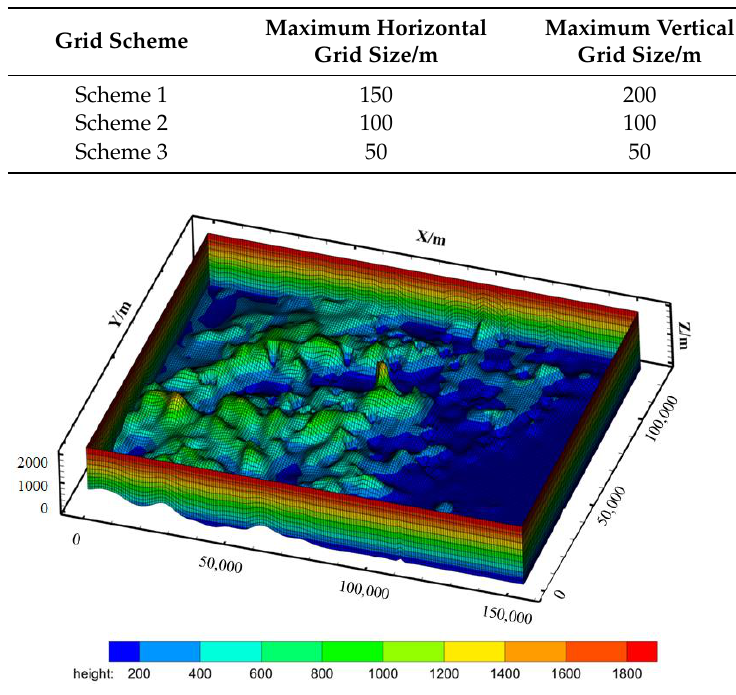
Table 4. Grid sensitivity analysis schemes.